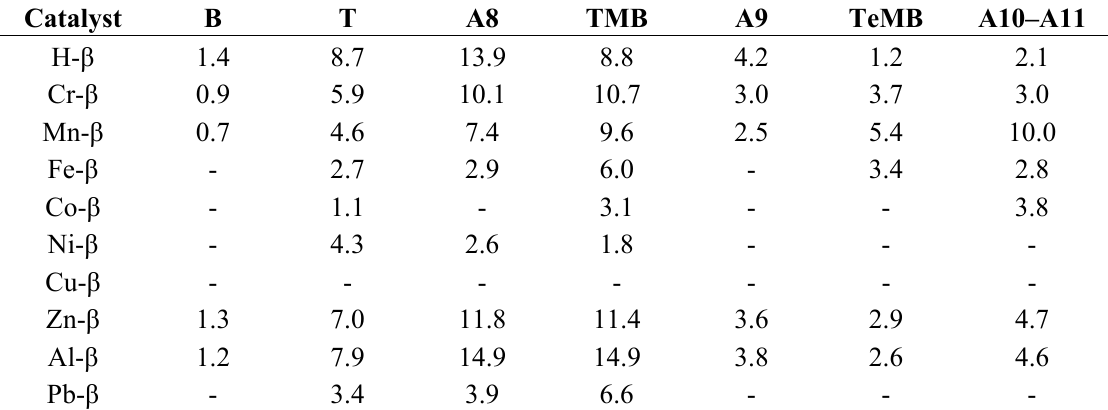
Table 5. Relative yields (wt %) to the compounds present in the aromatic fraction.